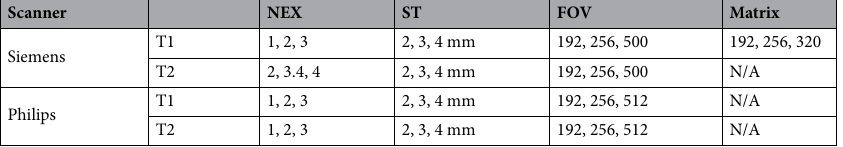
Table 8. The scanning protocols used with the Siemens and Philips 1.5 T MRI scanners. NEX number of excitation, ST slice thickness, FOV field of view.